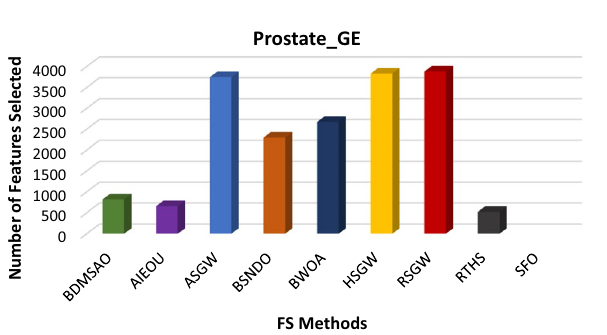
Figure 12. The number of features selected by BDMSAO and other FS methods on the Prostate_GE